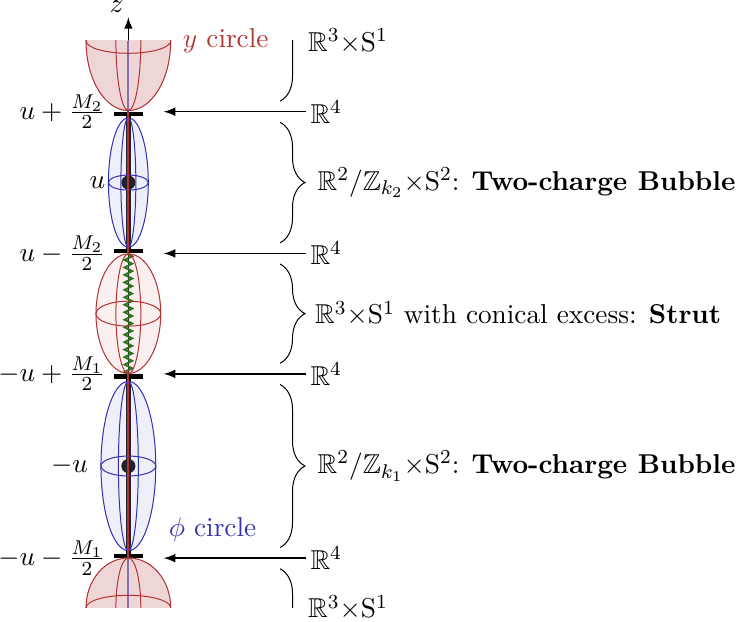
Figure 7 . The profile of the solutions along the z -axis. We have depicted the behavior of the y -circle in red which shrinks on the rods and have a finite size otherwise and of the φ -circle in blue which has a finite size on the rods and shrinks otherwise. The electric and magnetic fluxes are wrapped on the blue bubbles on the